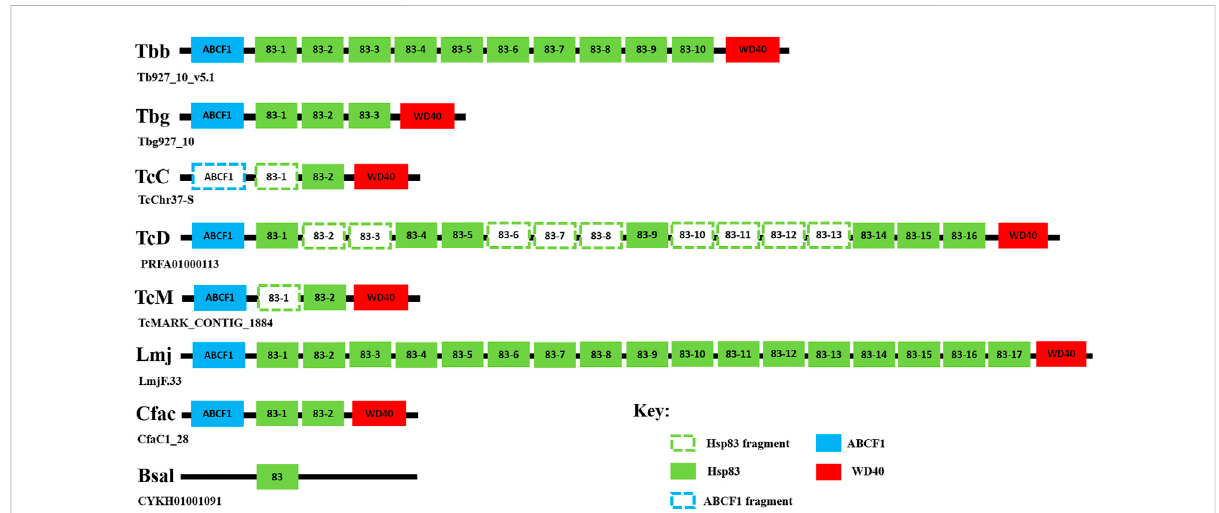
FIGURE 1 Syntenic analysis of the gene arrangement of the HSP83 genes in T. brucei and selected trypanosomatids. The conserved syntenic regions surrounding the selected HSP83 genes were searched by examining the conserved co-localization of neighboring genes on chromosome 10 on a scaffold of the T. brucei subspecies, T b. brucei (Tbb), and T b. gambiense (Tbg), and selected trypanosomatids: T. cruzi CL Brener Esmeraldo-like (TcC), T.cruzi Dm28c2018 (TcD)strain, T.cruzi marinkelli strainB7(TcM), L.major (Lmj), B.saltans (Bsal), and C.fasciculata (Cfac).Thegenome information used for this study was acquired from the TriTrypDB database (http://tritrypdb.org/tritrypdb/) (Aslett et al., 2010). The identities of unknown neighbor genes of the selected HSP83 genes were conducted using a BLASTP search on the NCBI database. Abbreviations: ABCF1: ATP- binding cassette sub-family F member 1; WD40: WD40-repeat